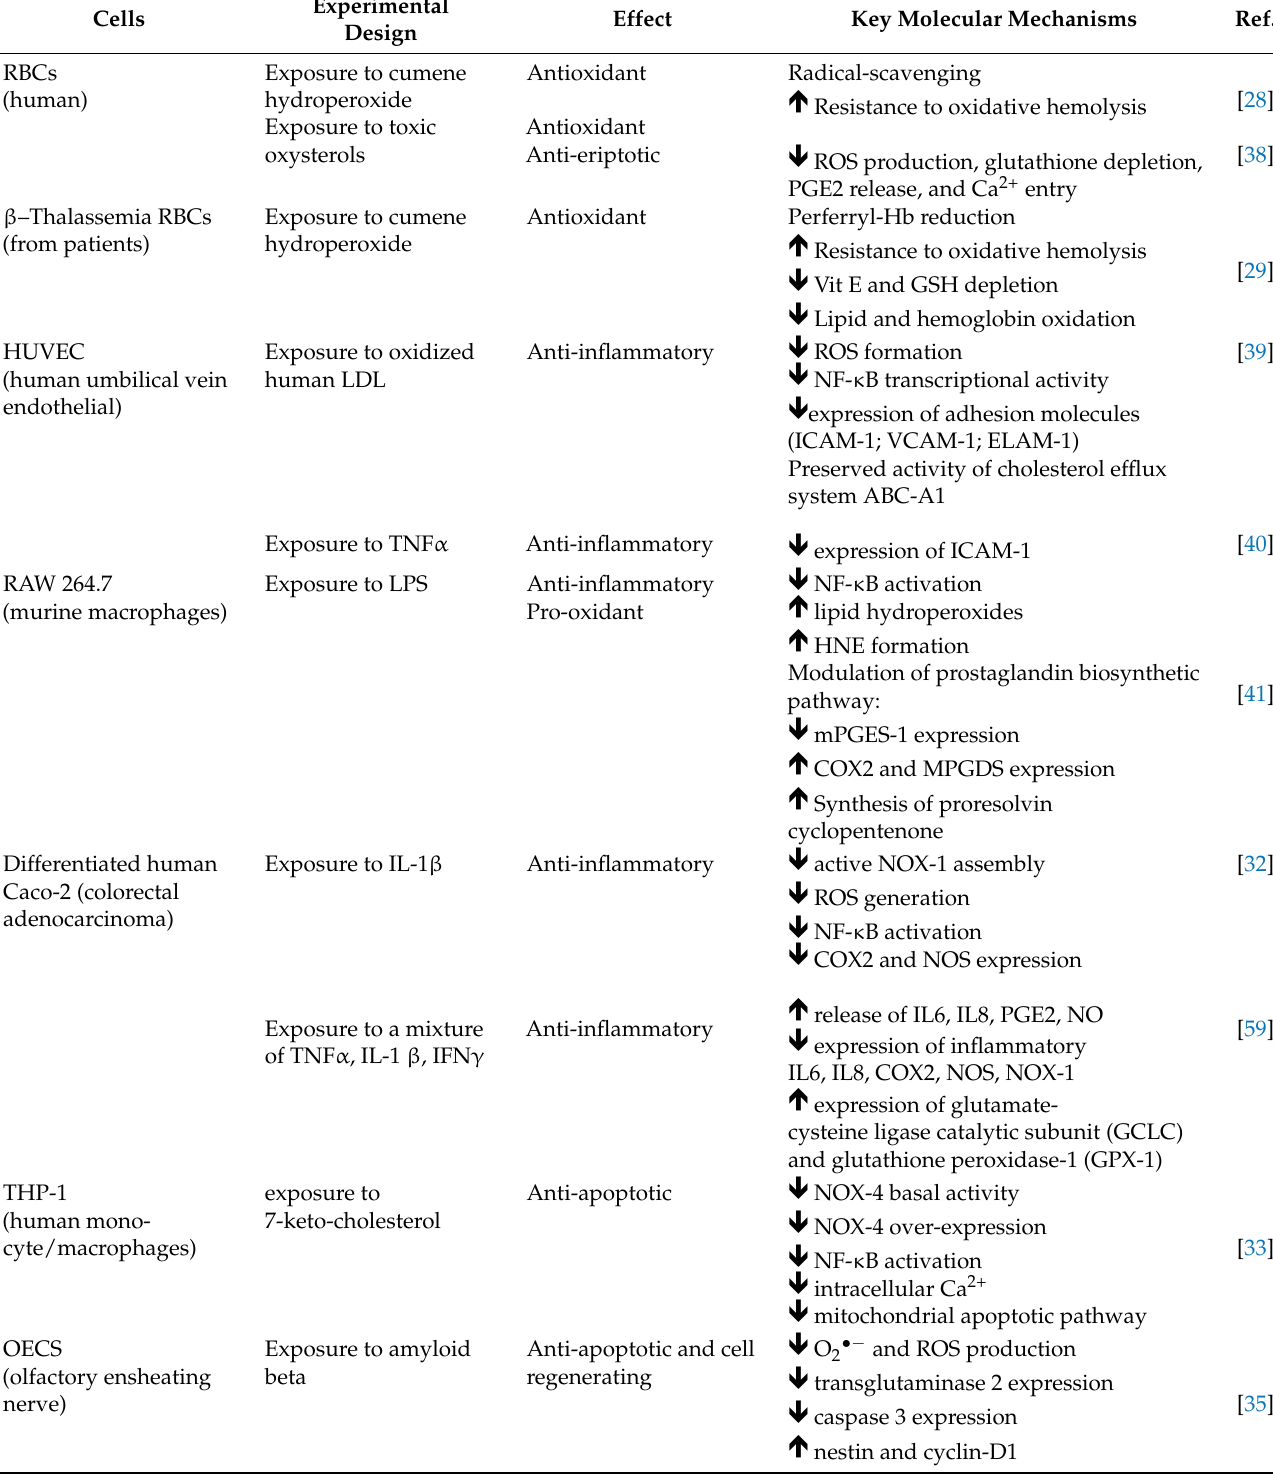
Table 3. Bioactivities of Indicaxanthin in cells and tissues. Table 5. Activity of Indicaxanthin in C. elegans. Table 6. Activity of Indicaxanthin in murine models. Table 6. Activity of Indicaxanthin in murine models.